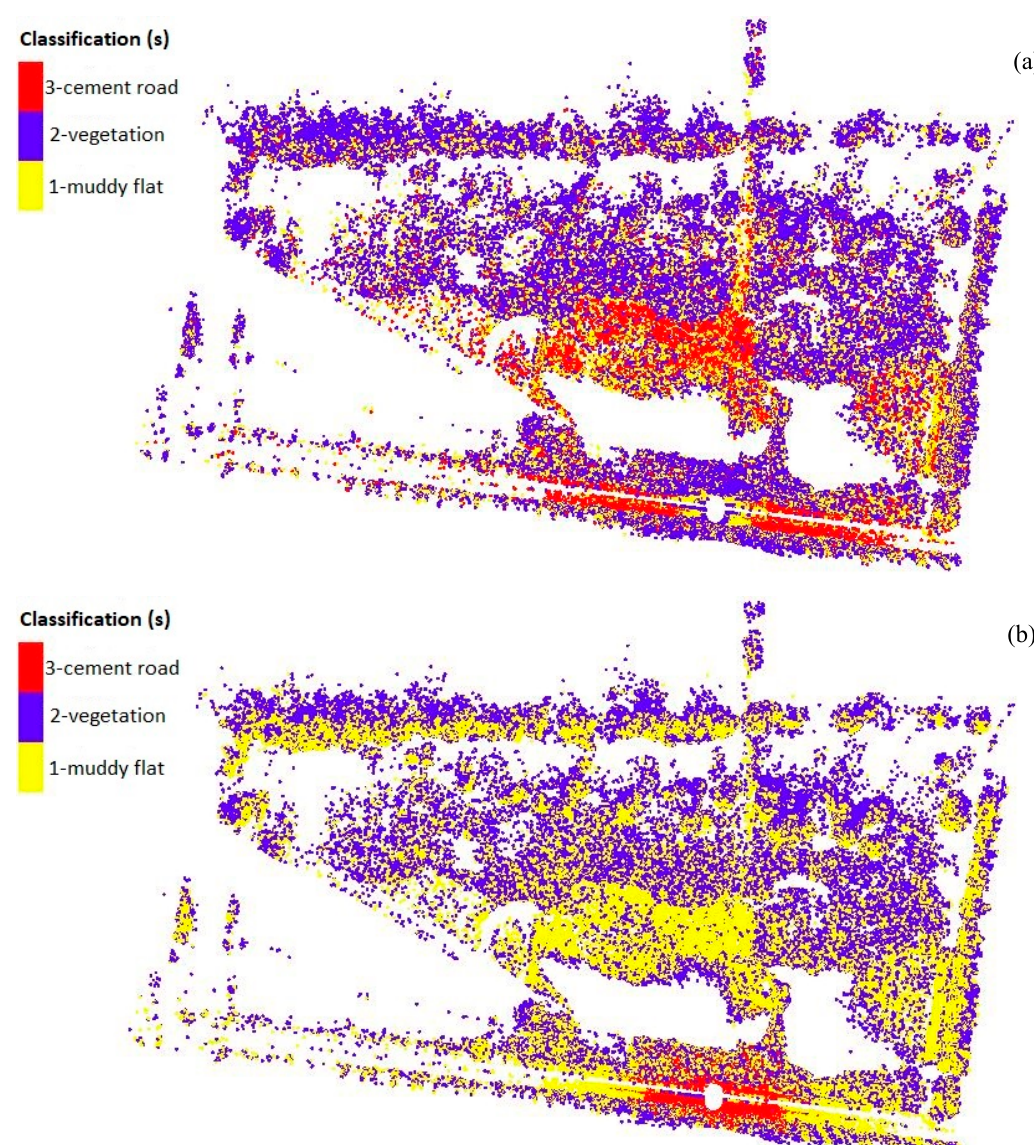
Figure 11. Classification results according to the intensity data of the improved method using k-means clustering. ( a ) Incidence angle-corrected intensity data. ( b ) Distance-corrected intensity data.